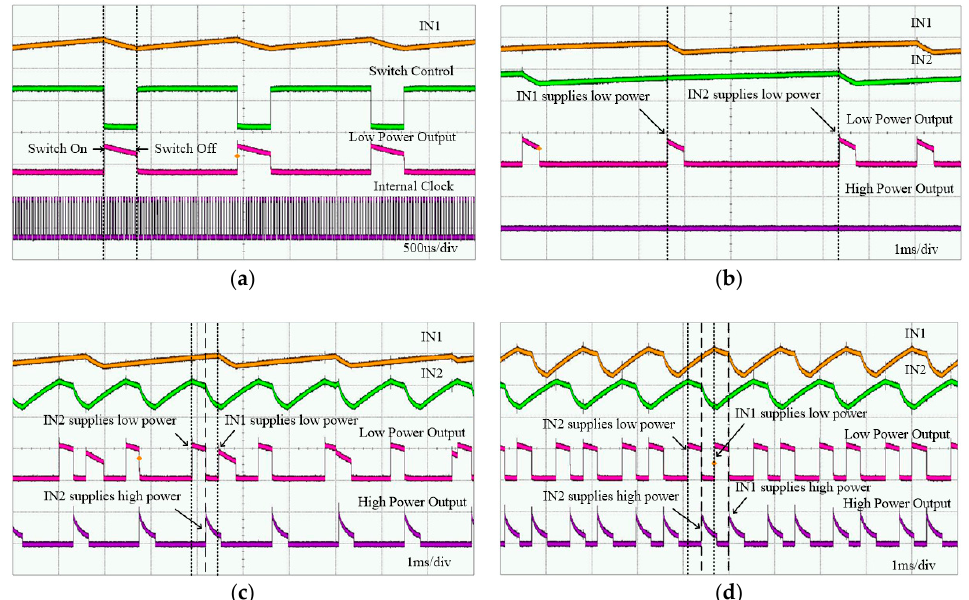
Figure 10. Energy managing waveforms in the newly developed IC. ( a ) Internal waveforms in EMIC with one energy harvester; ( b ) IN1: low power, IN2: low power; ( c ) IN1: low power, IN2: high power; ( d ) IN1: high power, IN2: high power.